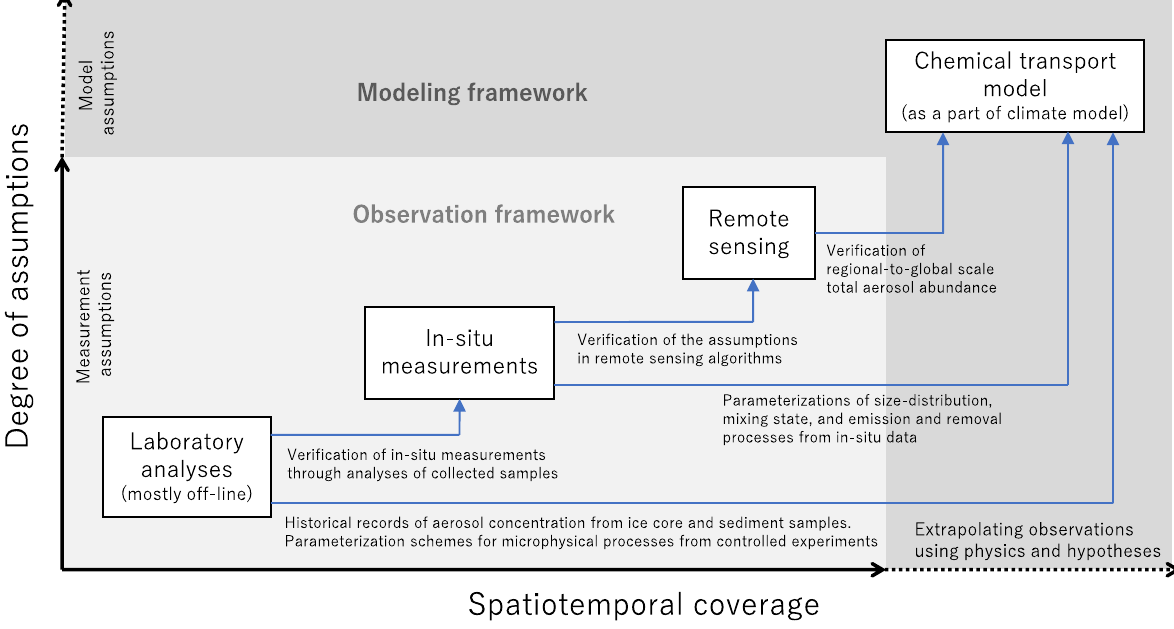
Fig. 1 Roles and relationships of the four different approaches in aerosol-climate research. Laboratory analyses of collected samples, in situ measurements, and remote sensing provide complementary observational information needed for reducing assumptions in the atmospheric chemical transport model (sub-module of the climate